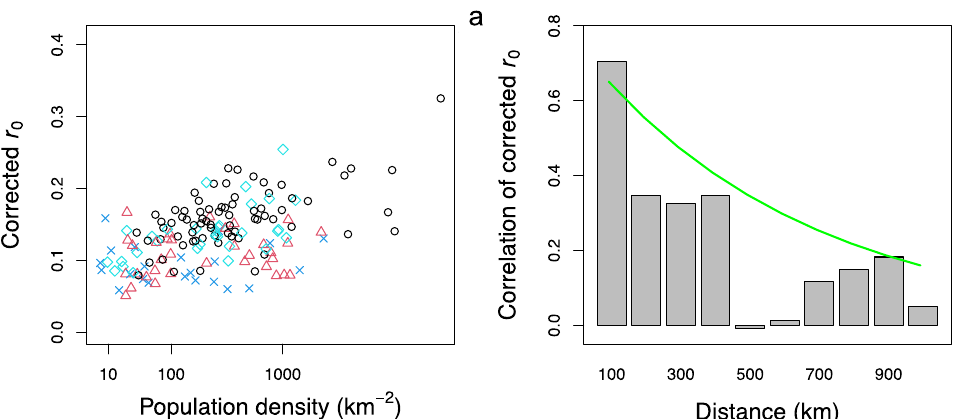
Fig. 2 Estimates of initial spread rates, r 0 , after correcting for the effects of outbreak onset and population size. a Effect of population density: Northeast, black circles; Midwest, cyan diamonds; South, blue x ’ s; West, red triangles. b Effect of spatial proximity depicted by computing correlations in bins representing 0 – 100 km, 100 – 200 km, etc. The line gives the spatial autocorrelation of the residuals from the fi tted regression (Eq.